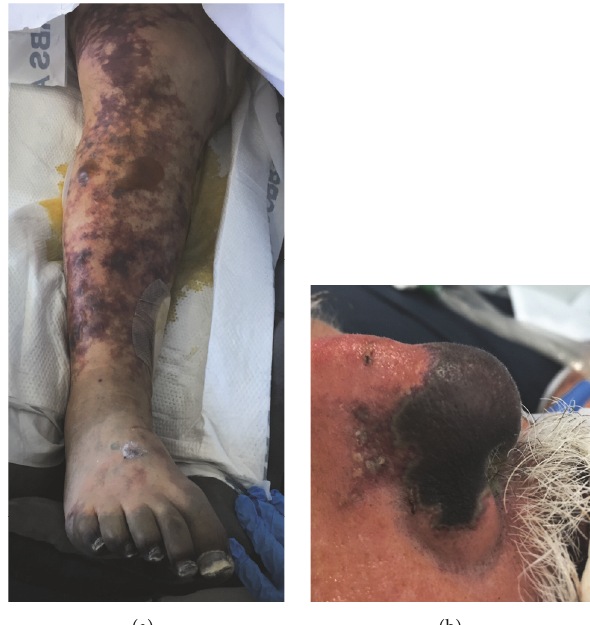
Figure 1: (a) Hospital day 9. Well-demarcated,large ecchymotic rash with multiple large bullae to the right lower extremity and hemorrhagic necrosis to the distal digits and foot. (b) Hospital day 9. Necrosis involving the nasal supratip, tip, septum, and ala.